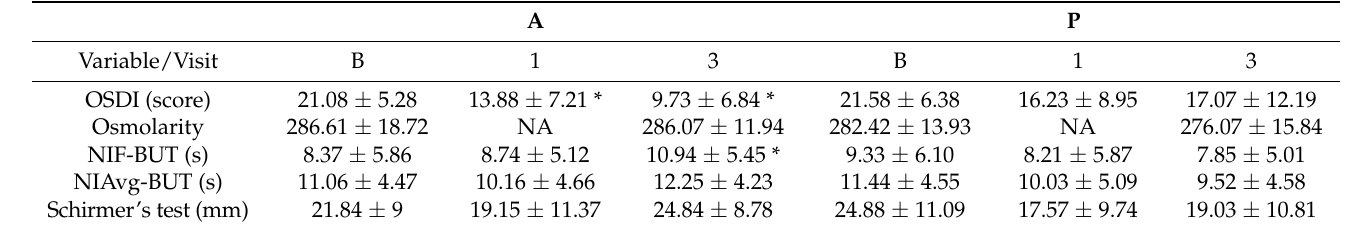
Table 5. Quantitative variables analysis in dry-eye patients exposed to the oral study formulation or